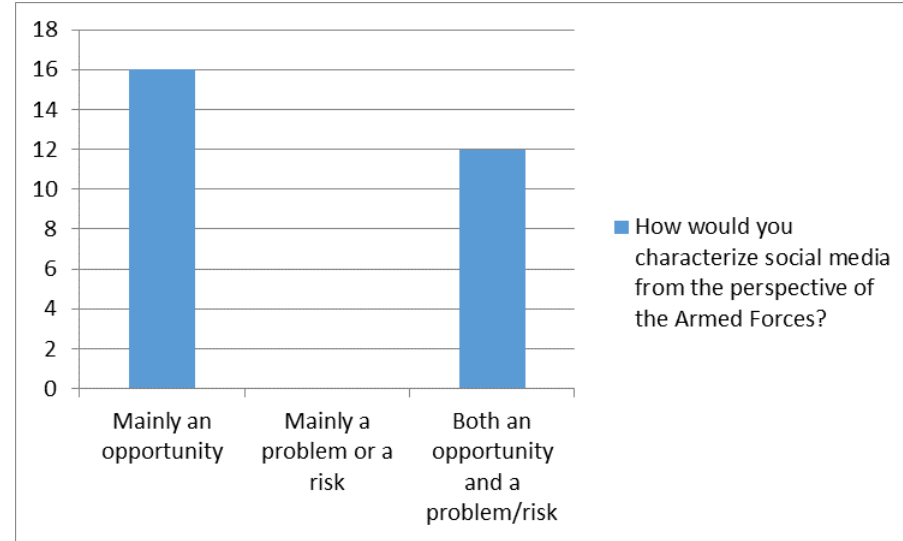
Figure 1. Views on social media as mainly a risk or as an